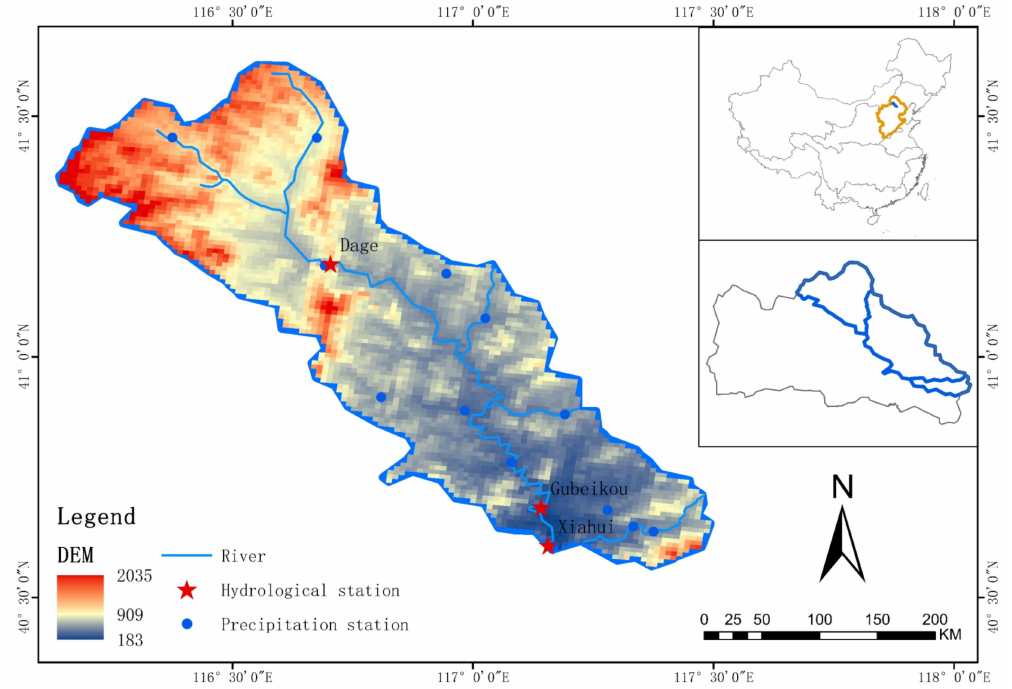
Figure 1. Map of the Chaohe River Basin including the digital elevation model (DEM), basin boundary, and locations of hydrological and precipitation